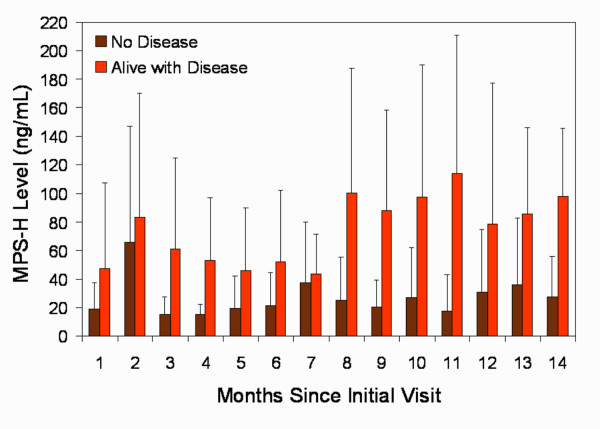
Serial MPS-H levels in HNSCC patients treated and without clinical disease (No Disease) and patients with unresectable disease or receiving palliative therapy with persistent clinical disease (Alive with Disease). Error bars denote 1 standard deviation and vary widely in the AWD group due to its small size and patient attrition over time from death.